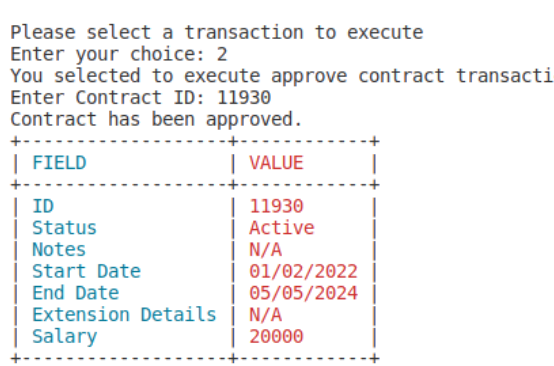
Figure 5. An employer peer issues “AddContract” to initiate a new employment contract and add it to the smart contract.